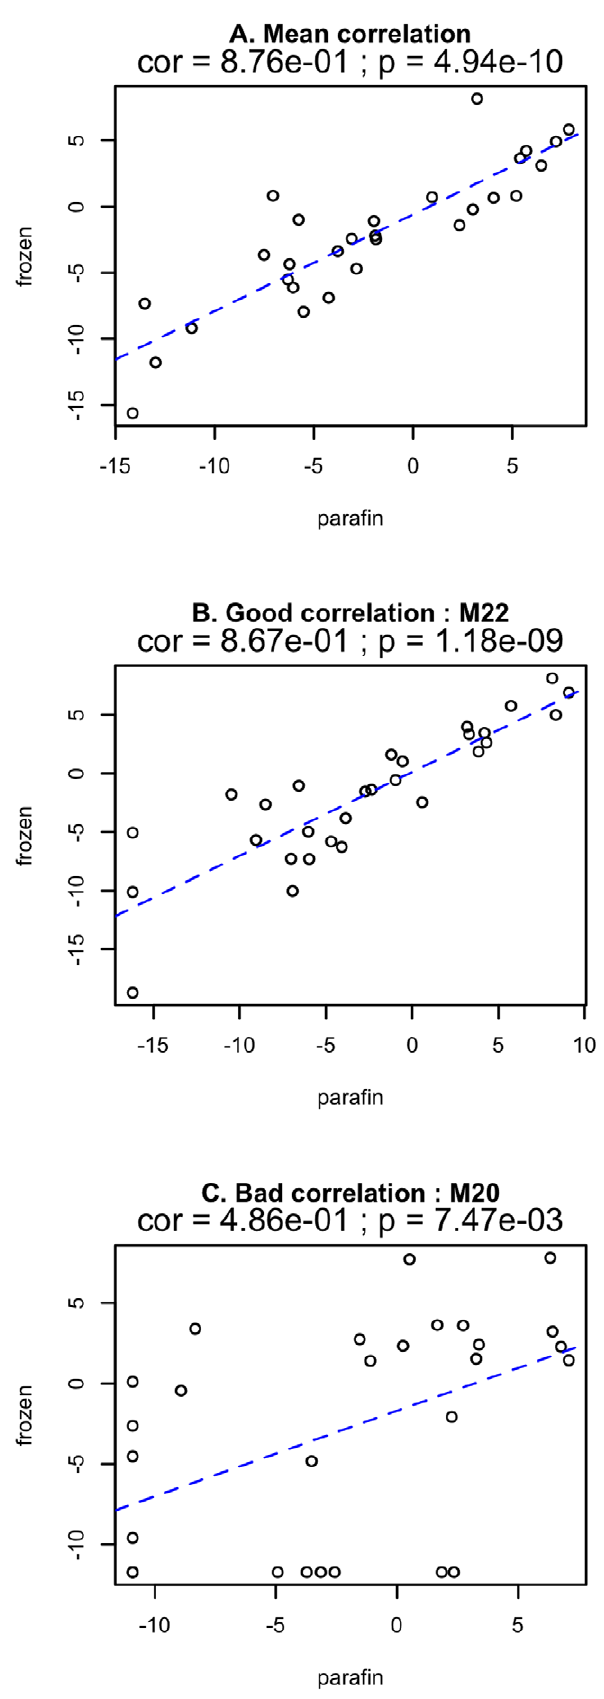
Figure 2. Frozen/FFPE correlations. a . Correlation in all the patients and for all the genes between the two tissue preparation methods. The adjusted Pearson correlation between FFPE and frozen tissue for all tested genes was greater (Pearson coefficient=0.88 p , 0,0001). b . Two examples of correlations determined individually for each patient measured in all